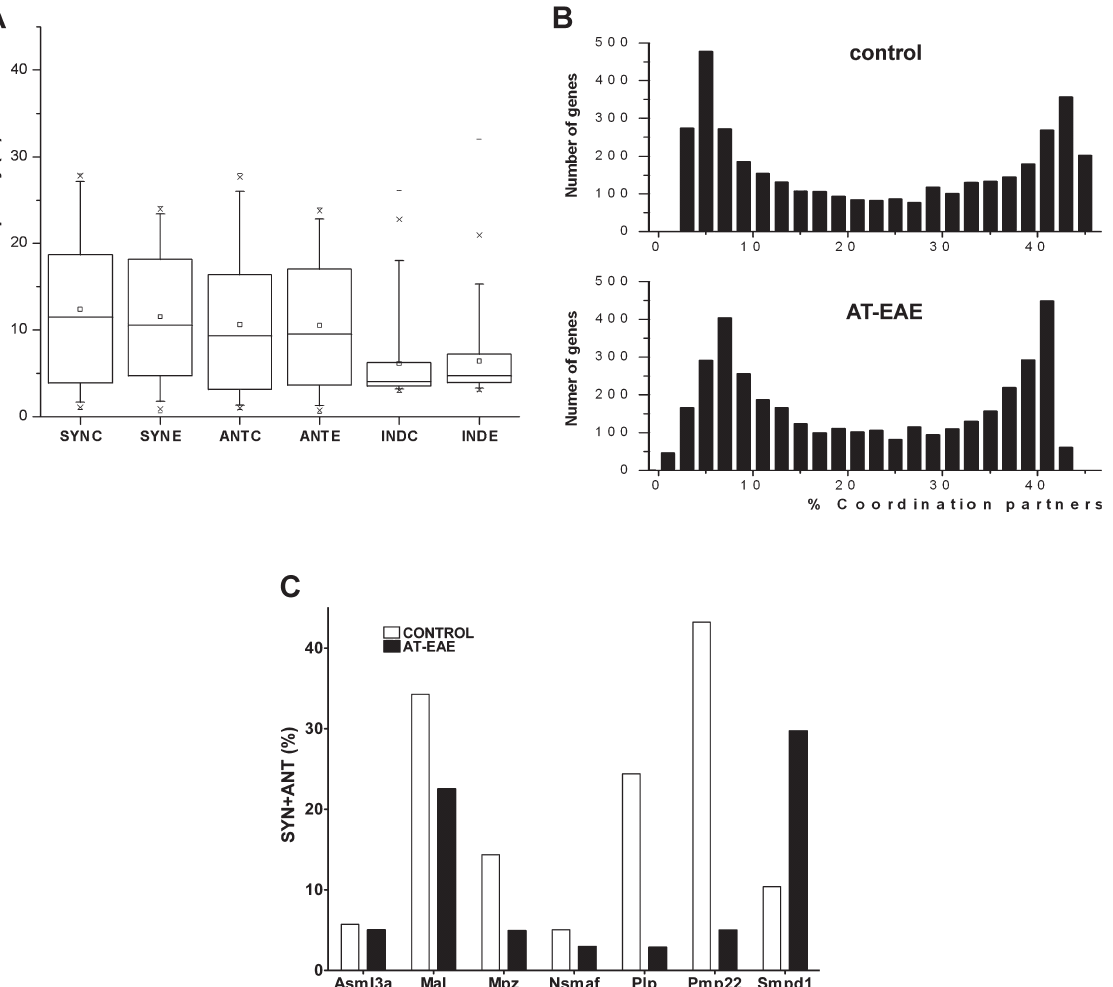
Figure 3. Transcription coordination. ( A ) The 95% confidence intervals of the percentages of synergistically (Syn), antagonistically (Ant), and independently (Ind) expressed gene pairs in spinal cord of control (C) and AT-EAE (E) mice. Note that the intervals remained practically unchanged in AT-EAE. ( B ) Histograms of the expression coordinations (SYN þ ANT) in control and AT-EAE spinal cord. Note the two modal distributions in both conditions, with two distinct groups of genes: one group in which most genes are coordinately expressed with 4–8% of the other genes and the second group in which most genes are coordinately expressed with 40–44% of the other genes. ( C ) Examples in which percentages of statistically significant coordination partners of myelination genes differed between control and AT-EAE spinal cords. Chk, choline kinase; Fyn, Fyn proto-oncogene; Hmgcr, 3-hydroxy-3-methylglutaryl-coenzyme A reductase; Mal, myelin and lymphocyte protein T-cell differentiation protein; Mpz, myelin protein zero; Nsmaf, neutral sphingomyelinase activation-associated factor; Pdgfra, platelet derived growth factor receptor alpha polypeptide; Pdgfrb, platelet derived growth factor receptor beta polypeptide; Pdgfrl, platelet-derived growth factor receptor-like; Plp, proteolipid protein; Pmp22, peripheral myelin protein; Qk, quaking; Scd1, stearoyl-coenzyme A desaturase 1; Scd2, stearoyl-coenzyme A desaturase 2; Smpd1, sphingomyelin phosphodiesterase 1 acid lysosomal; Smpdl3a, sphingomyelin phosphodiesterase acid-like